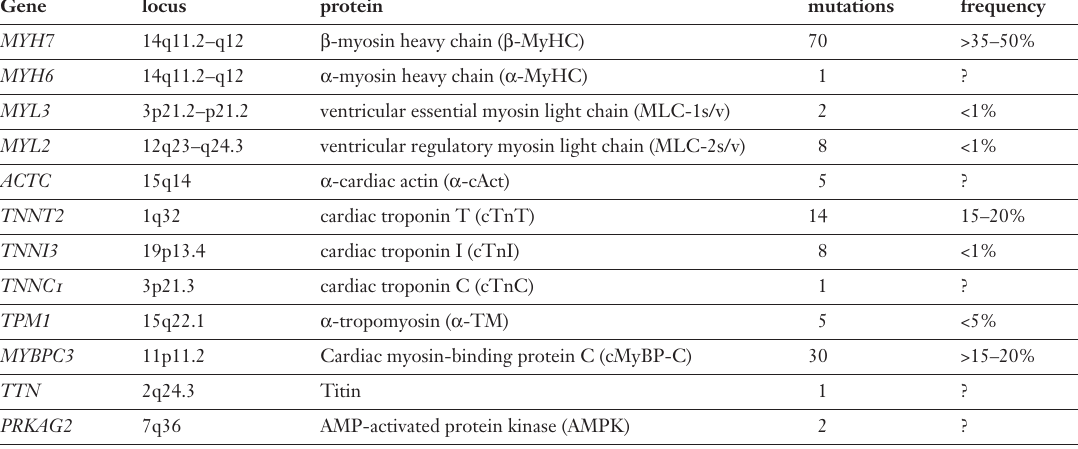
AMP-activated protein kinase (AMPK) Eleven FHC genes code for sarcomeric proteins: genes MYH7, MYH6, MYL2 and MYL3 code for the thick filament proteins, genes TNNC1, TNNI3, TNNT2, TPM1 and ACTC for the thin filament proteins, and gene MYBPC3 codes for the myosin- binding protein C. The titin-protein, coded by TTN, is the third filament of the sarcomere. Gene PRKAG2 codes for the g 2-subunit of the AMP-activated protein kinase. The last column indicates the frequency of the mutations found in the different genes.